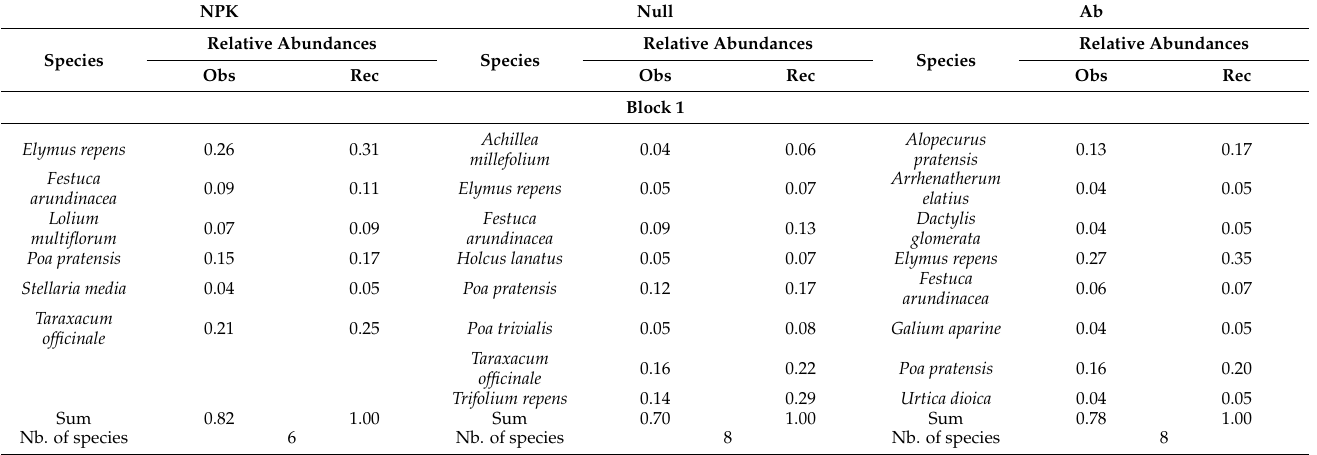
Table 2. Relative abundances of dominant species (two blocks and three treatments). Mean